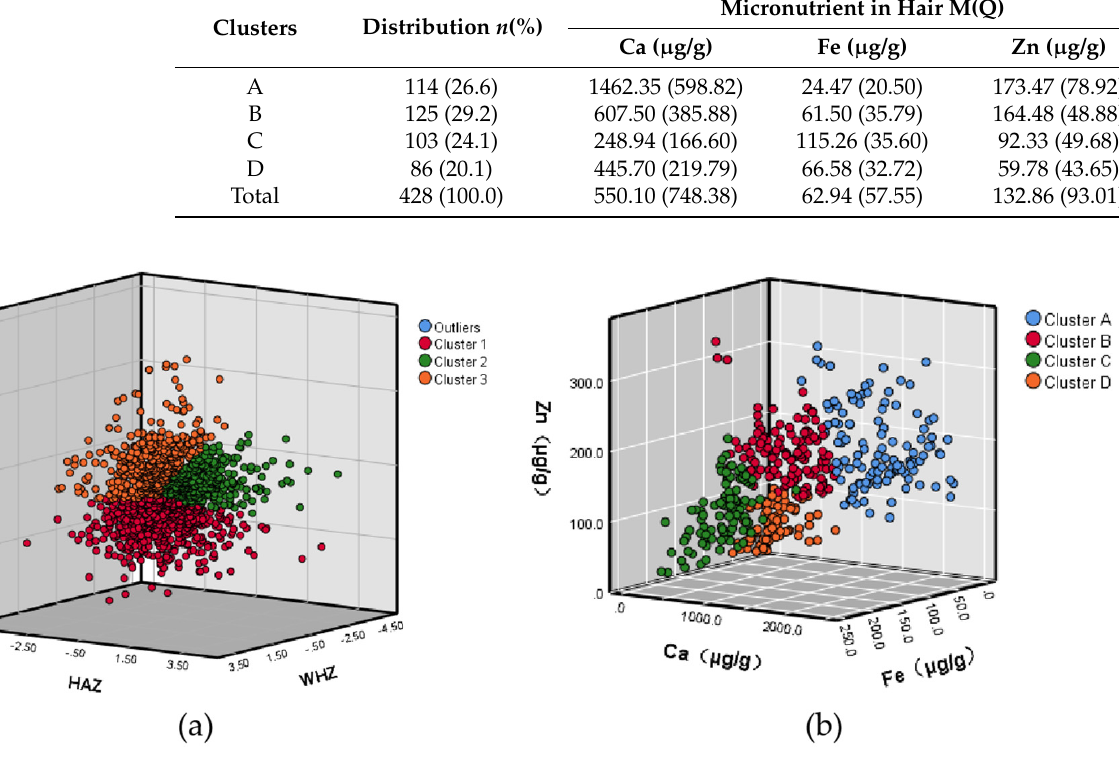
Table 4. The CF status in IYC with different z-scores.